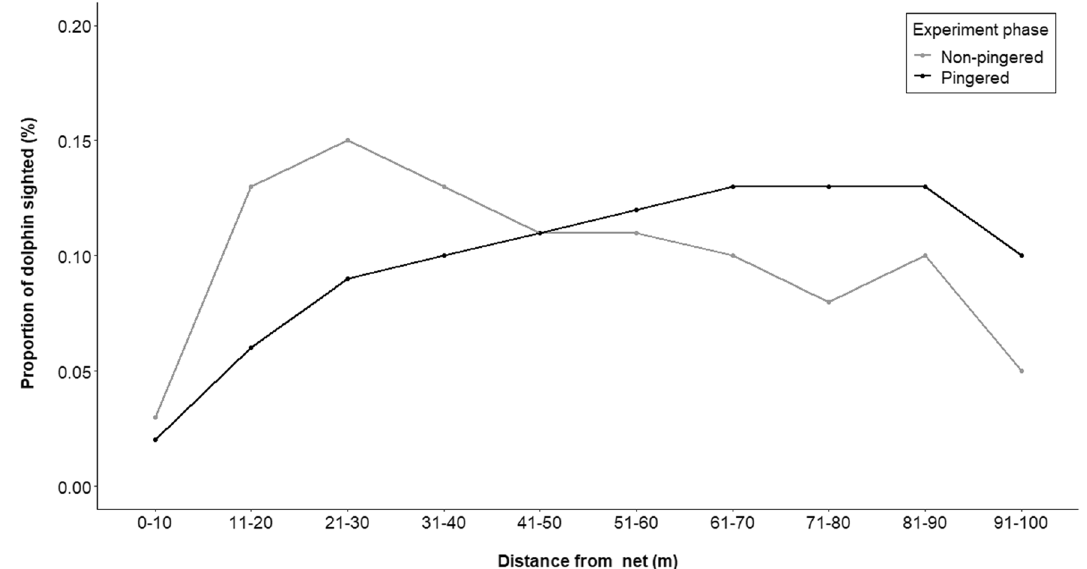
Figure 8. Proportion of non-calves sighted by visual observers during the pingered and non-pingered phases of the experiment at different distance classes.